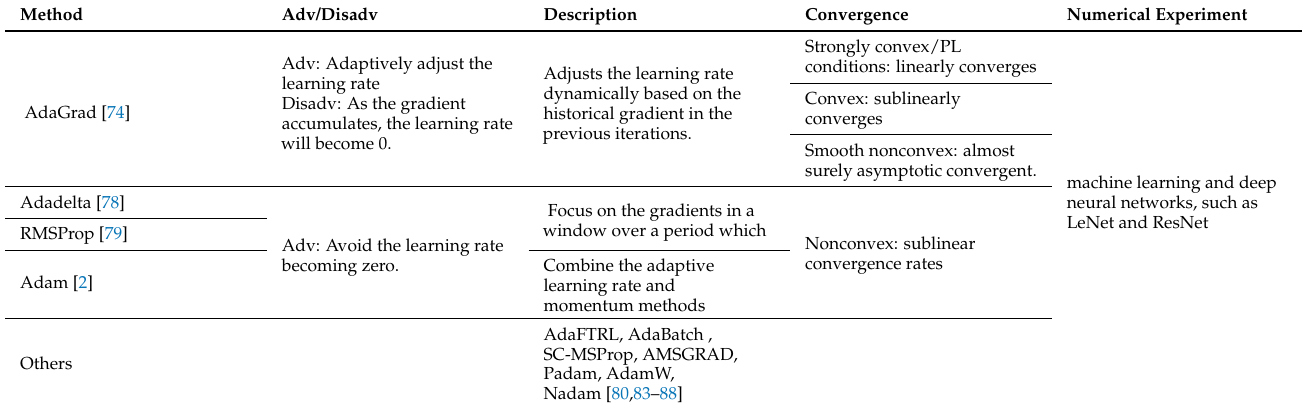
Table 5. Summary of the adaptive learning rate